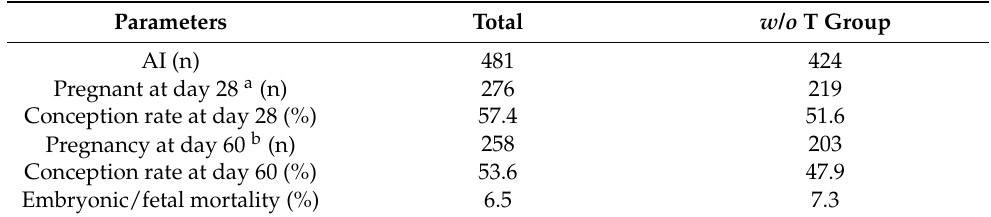
Table 1. Reproductive performance on all buffalo cows (total) and on buffalo without any treatment ( w/o T group) that underwent artificial insemination (AI). Parameters